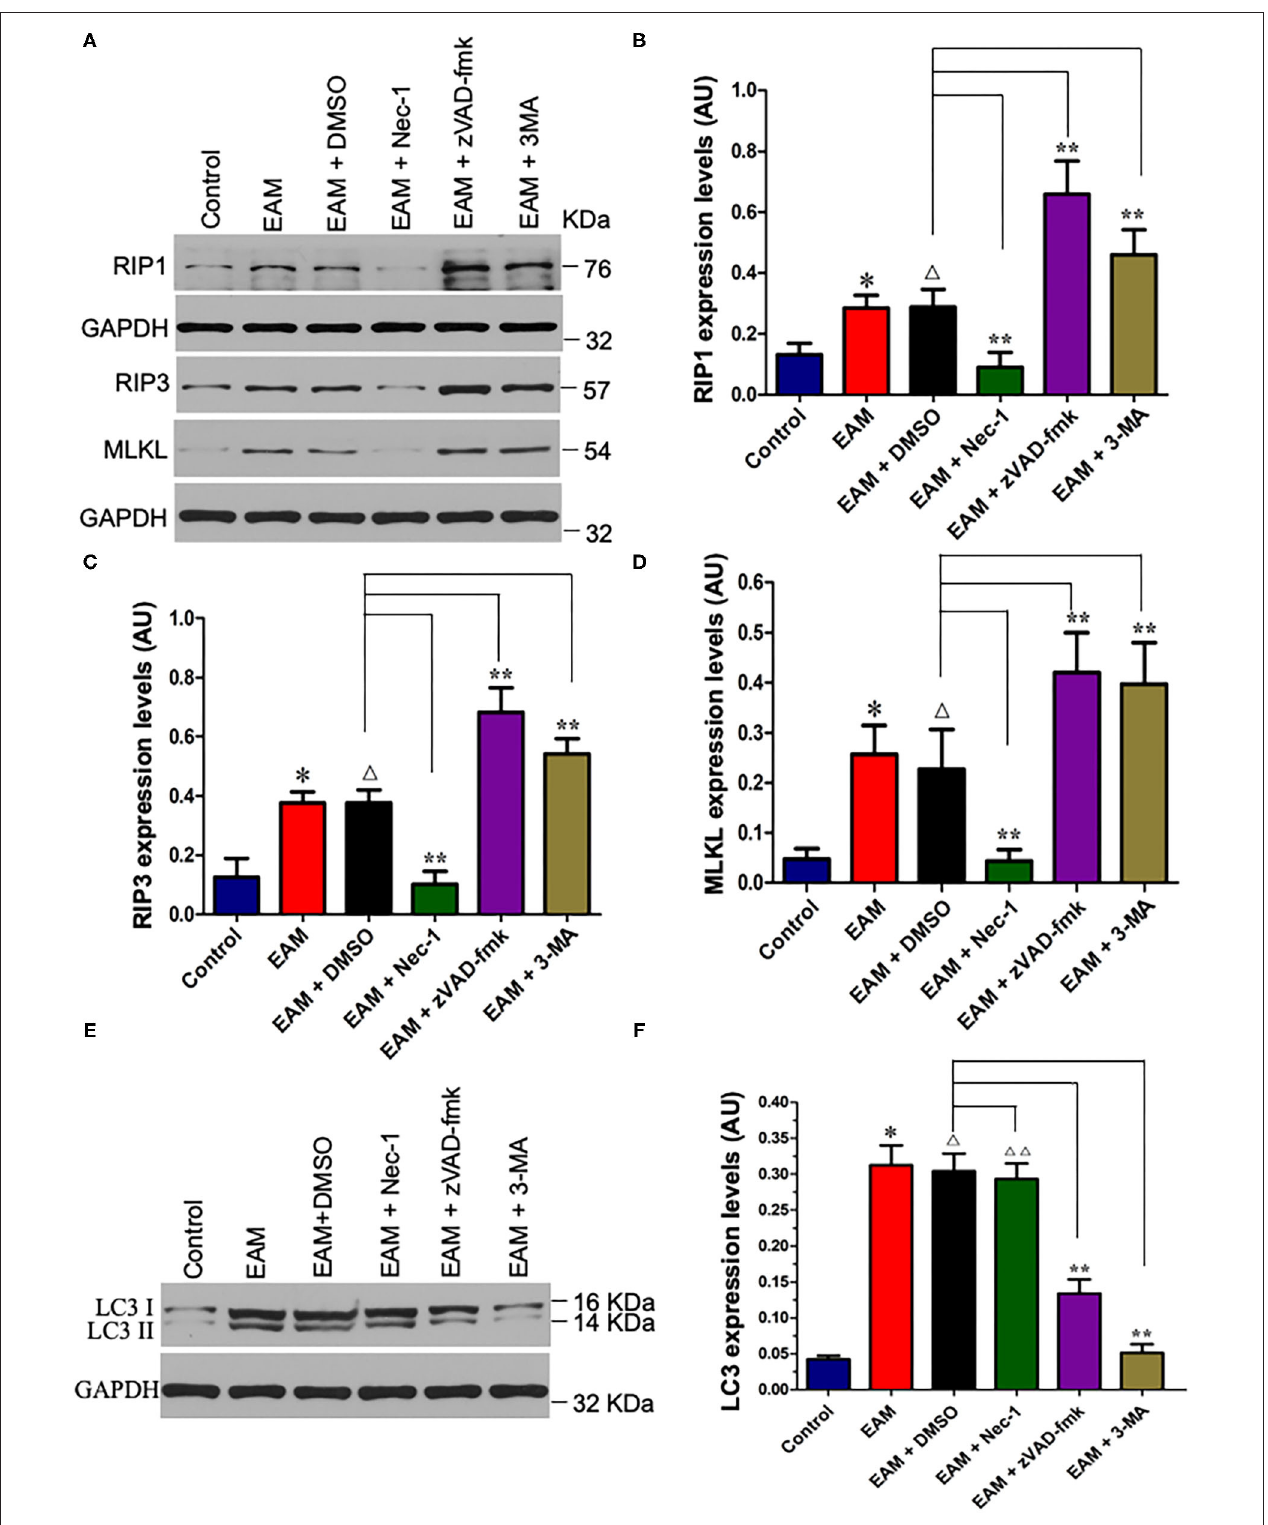
FIGURE 6 | Nec-I inhibits but 3-MA increases the expression levels of RIP1, RIP3, and MLKL in EAM. (A) Western analysis of protein expression levels of RIP1, RIP3, and MLKL in myocardial tissues from the control group; EAM (3W) group; EAM + DMSO group; and EAM + Nec-I, EAM + zVAD-fmk, and EAM + 3MA drug group. (B–D) Quantification of protein levels of RIP1 in b, RIP3 in c, and MLKL in d. Horizontal lines above bars indicate groups compared. All data are presented as